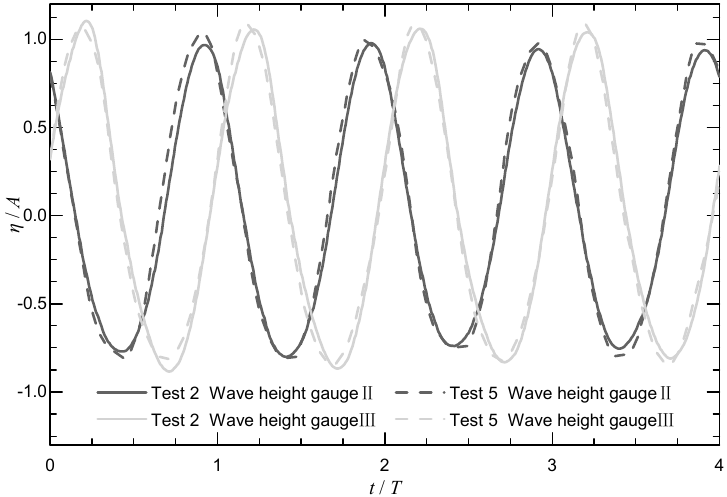
Figure 6. Comparations of wave profiles in section II and section III in test 2 (Waves: 𝐻 = 10 cm, 𝑇 = 1.5 s; no mat foundation; no current) and test 5 (Waves: 𝐻 = 10 cm, 𝑇 = 1.5 s; mat foundation: position A; no current).